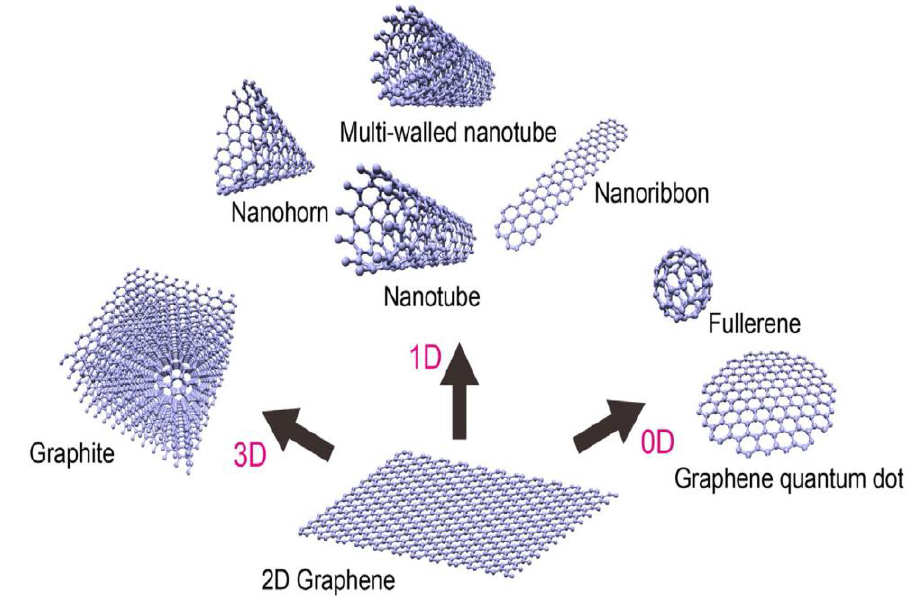
Figure 1. Carbonaceous materials of different dimensionalities. Reproduced from [24] with permission of Taylor & Francis.